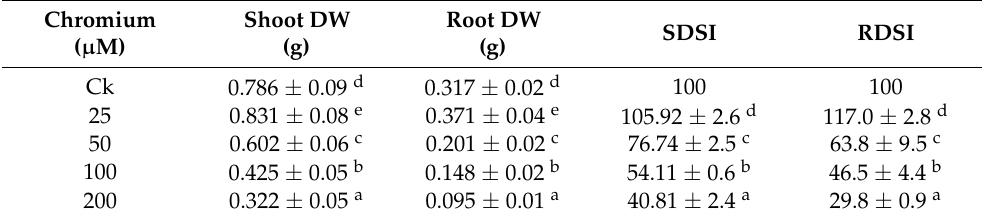
Table 2. Impact of Cr treatments on dry weight and susceptibility index of sweet